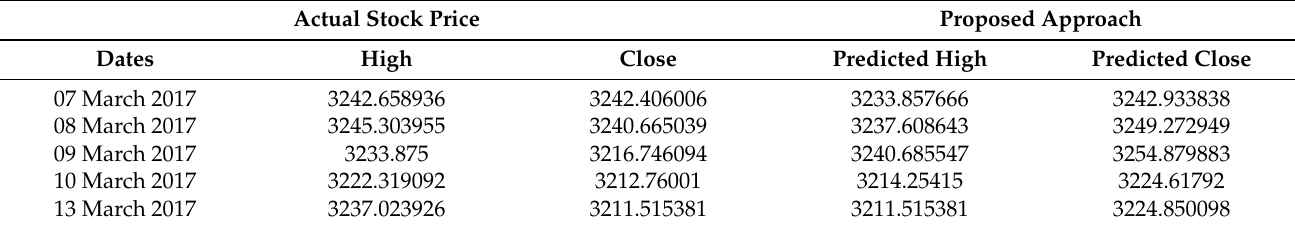
Table 6. Results of proposed methodology.